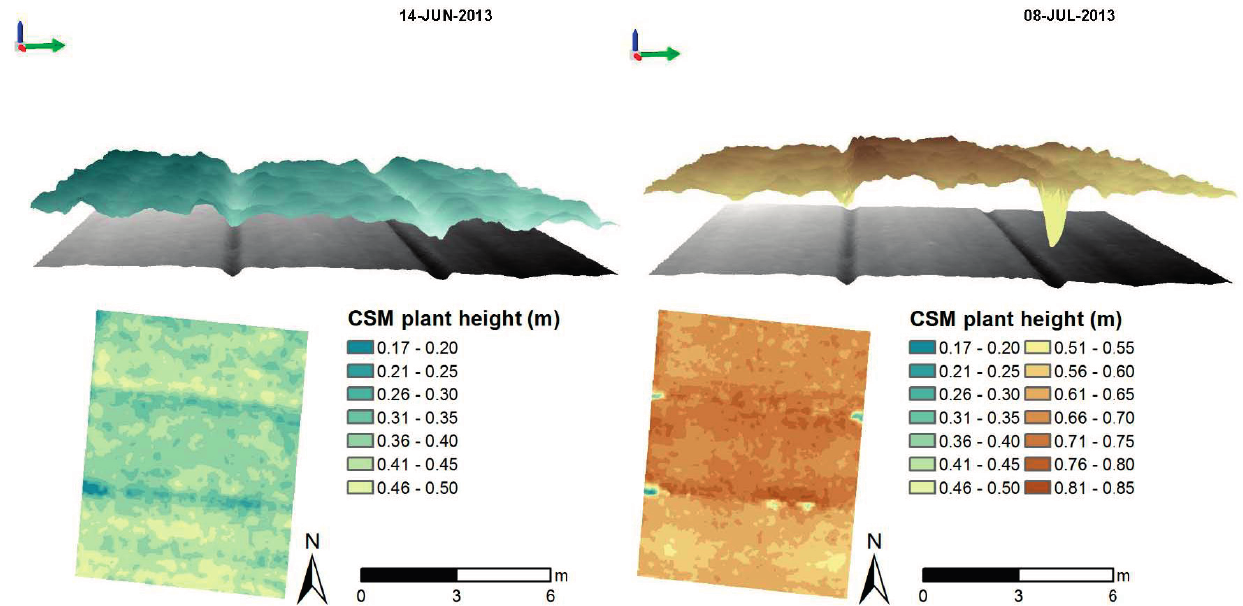
Figure 2. CSM over ground model ( top ) and derived plant height ( bottom ) of Plots 8, 7 and 1 (from left to right) of the eastern row of the test site for 14 June and 8 July